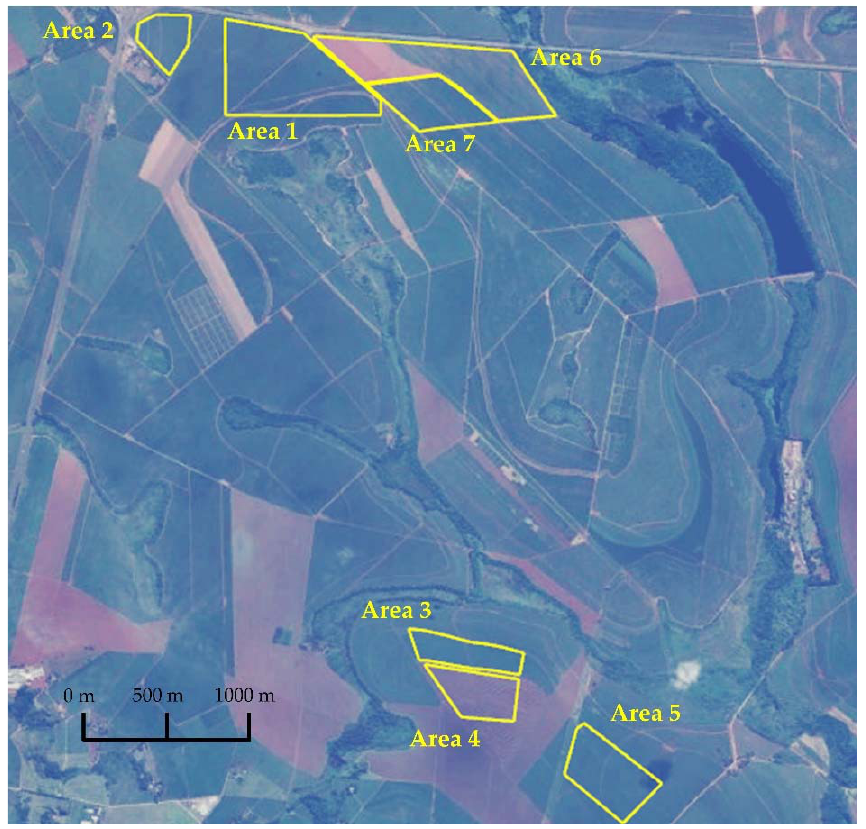
Figure 5. Test site–general view.